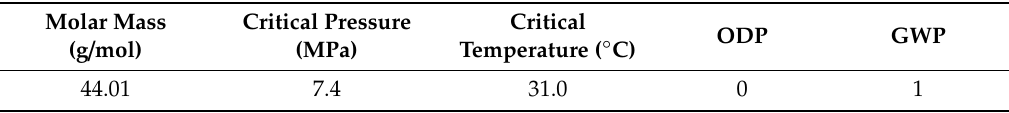
Table 2. Typical properties of (cid:1829)(cid:1841) (cid:2870) .